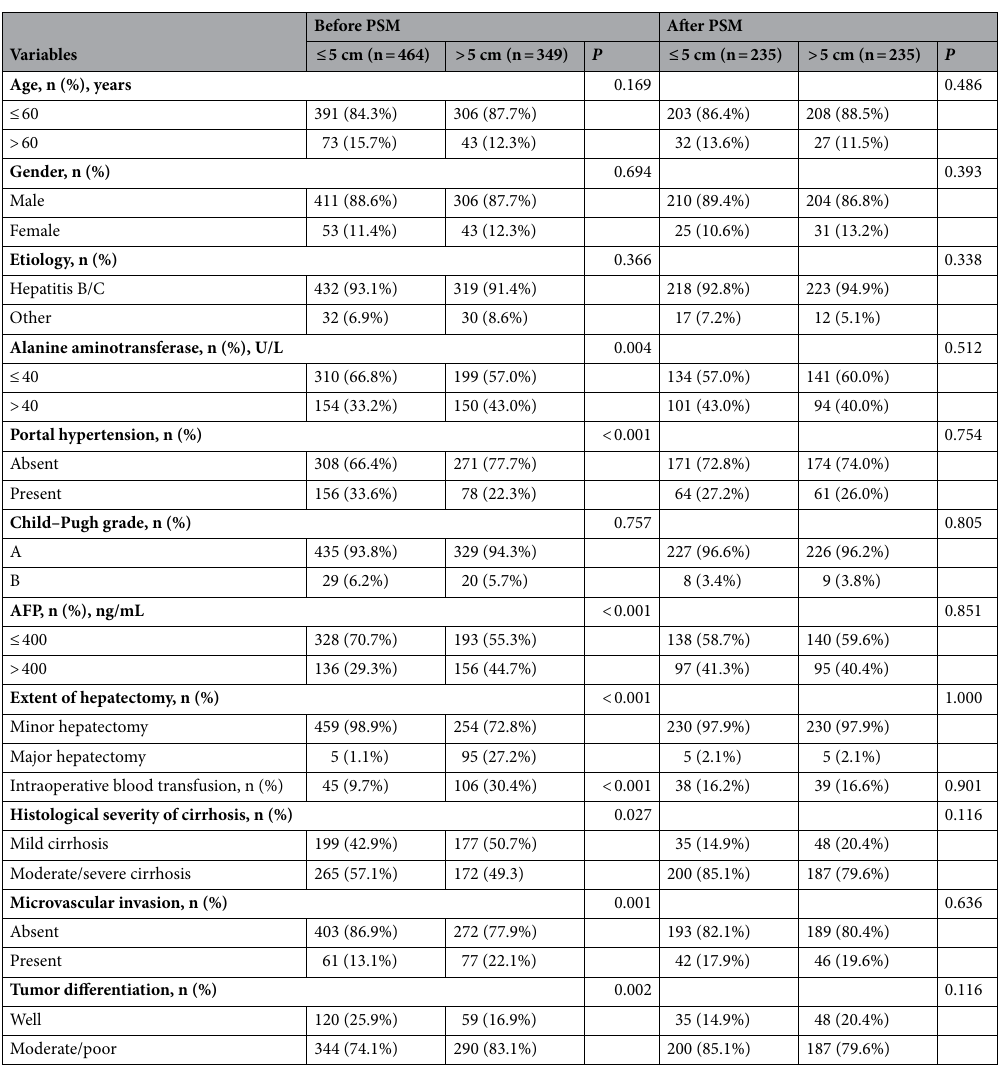
Table 2. Clinicopathological characteristics by tumor size and propensity score matching. PSM propensity score matching, AFP